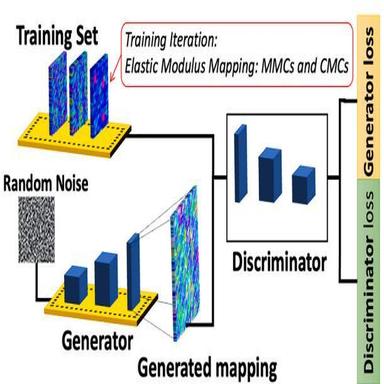
Flowchart schematic of Generative Adversarial Network's ground-truth (Training set), generator, discriminator, and loss calculations for elastic modulus mapping erroneous measurements filtration.